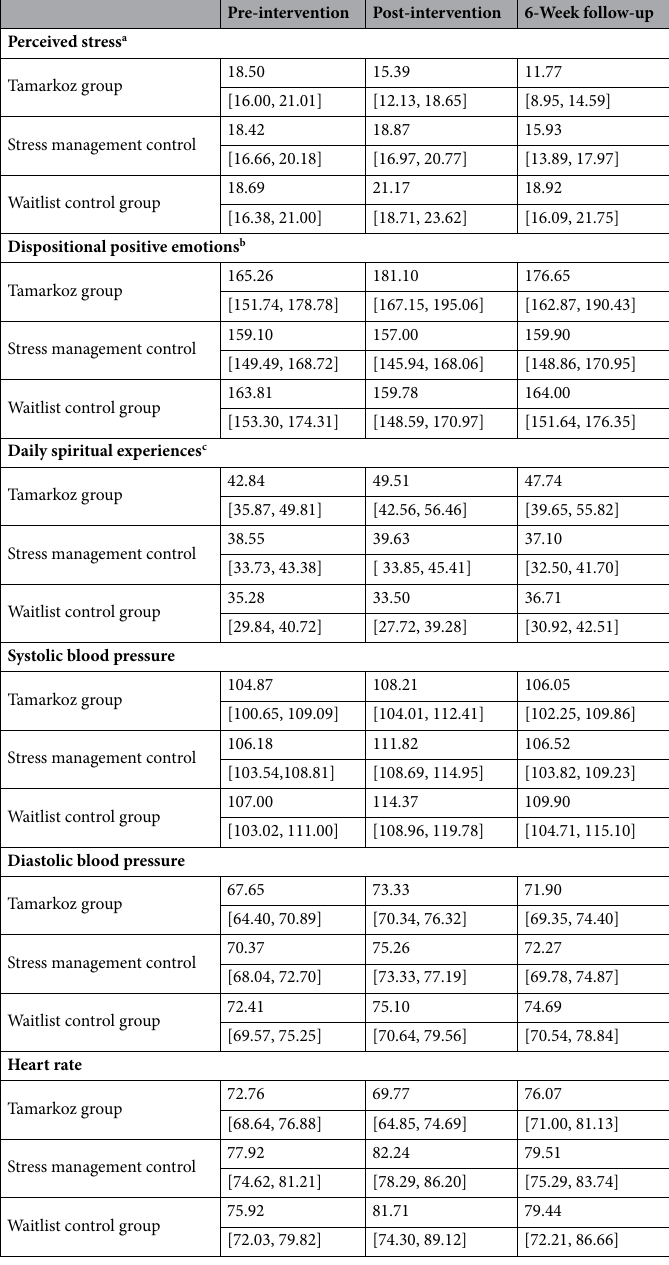
Minimum possible = 38. c Maximum possible = 94,